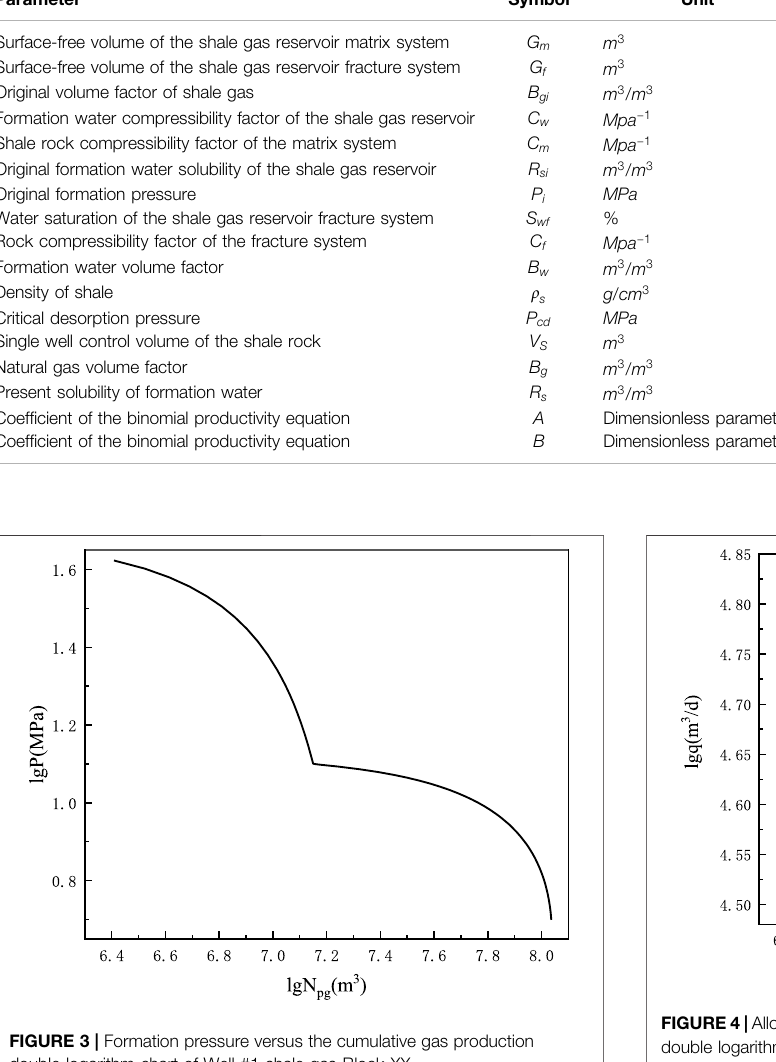
TABLE 2 | Formation physics and fl uid property of Well #1 shale gas Block XX. Parameter